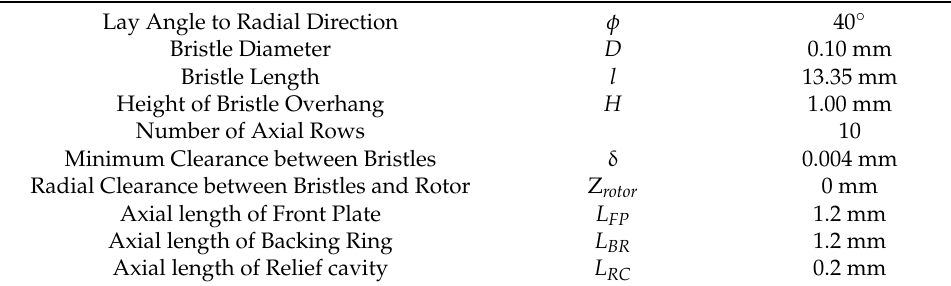
Table 1. Geometric parameters for the baseline model.